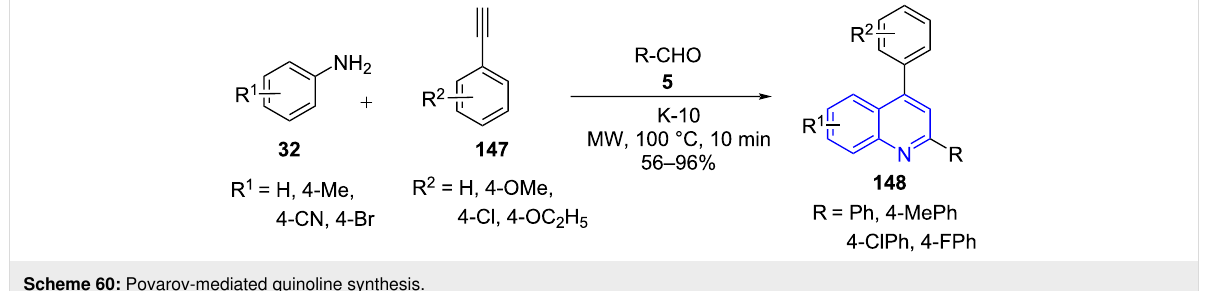
Scheme 60: Povarov-mediated quinoline synthesis.